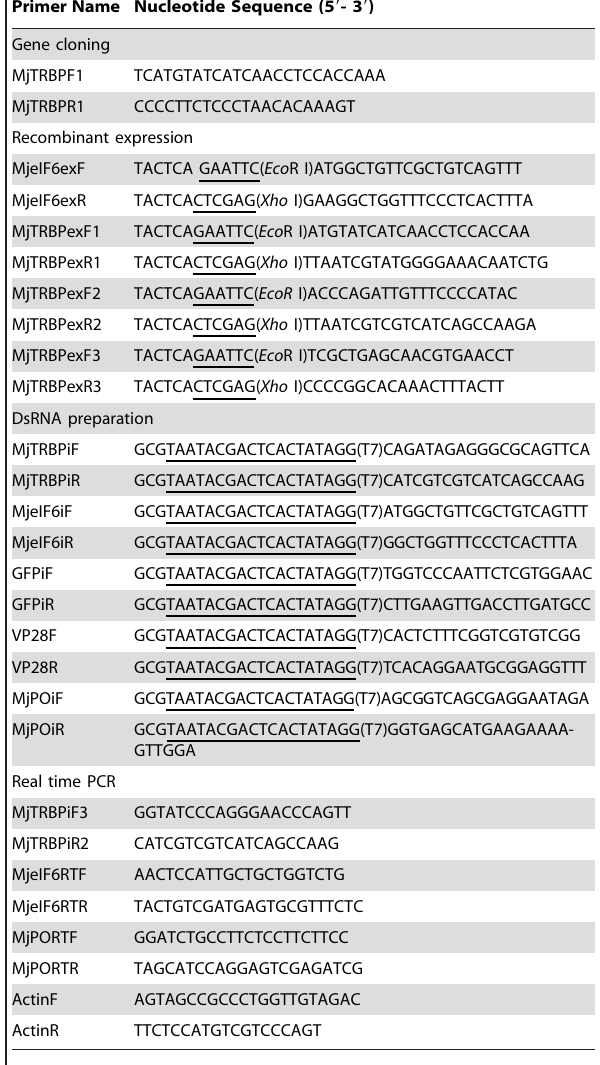
Table 1. Oligonucleotide primers used in this